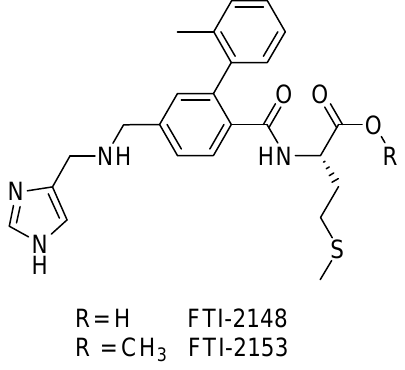
Figure 27. Chemical structures of compound FTI-2148 and its methyl ester prodrug FTI-